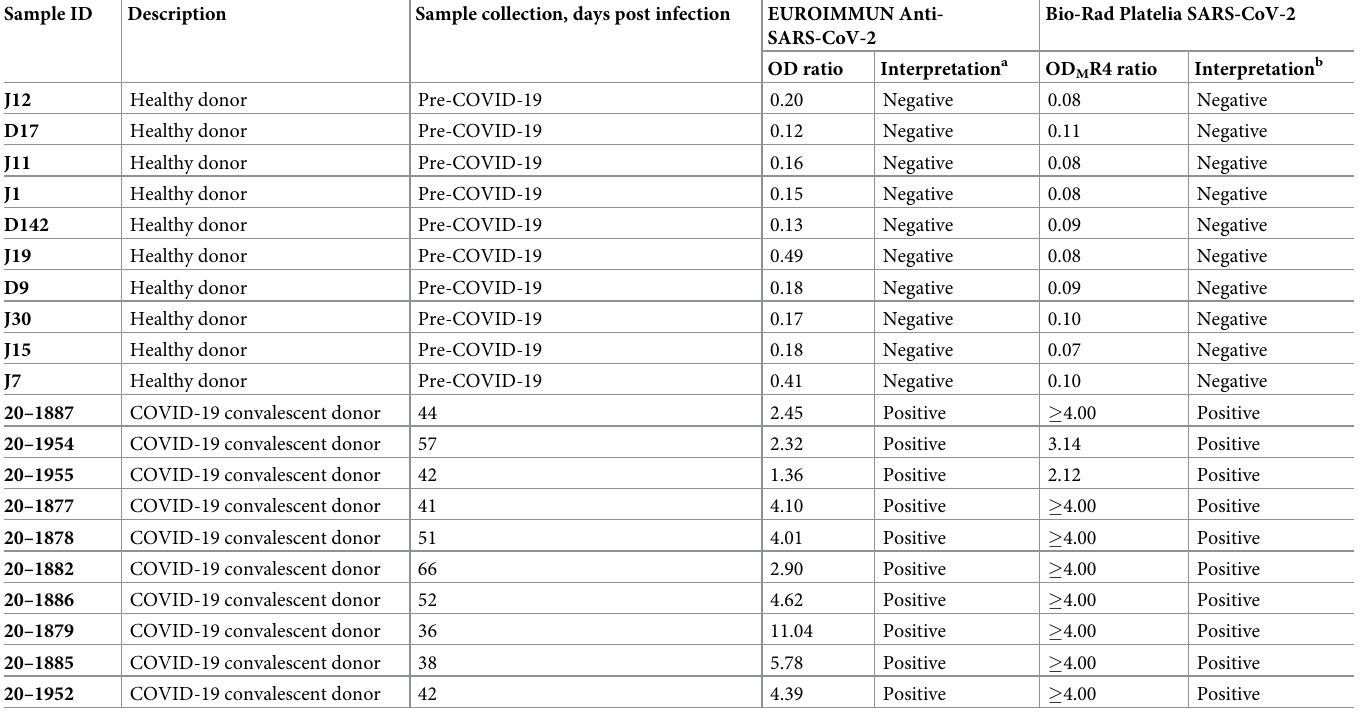
Table 3. SARS-CoV-2 antibody positive and negative plasma used to contrive dried blood spot specimens. Sample ID